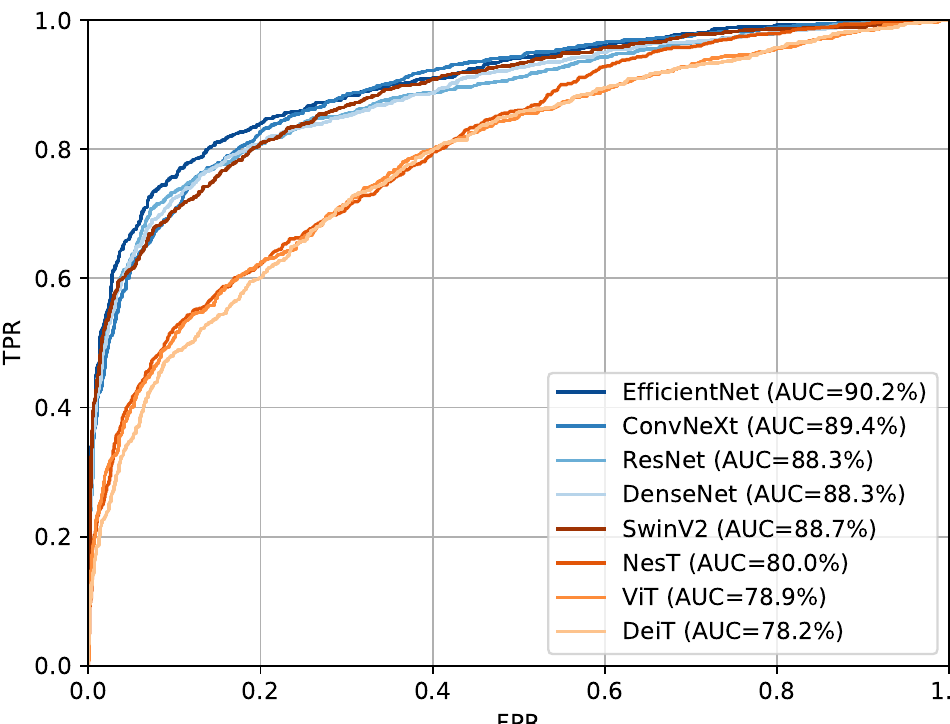
Figure 3. ROC curves of the best model for each of the eight families. In shades of orange are represented the convolutional models while in shades of blue the transformer-based models. In the legend the AUC value for each ROC curve is